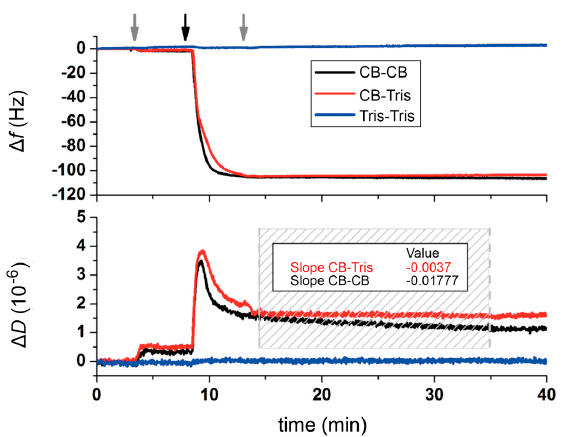
Figure 2. Real-time monitoring of rSbpA protein adsorption on hydrophobic silicon quartz crystal microbalance with dissipation (QCM-D) chips as recorded for frequency (top) and dissipation (bottom). Grey arrows indicate buffer injection, while the black arrow refers to injection of rSbpA monomeric solution. A dashed box highlights the post-rinse region employed to fit a linear dissipation decay. Respective slopes of the fitting curves are shown in the box.